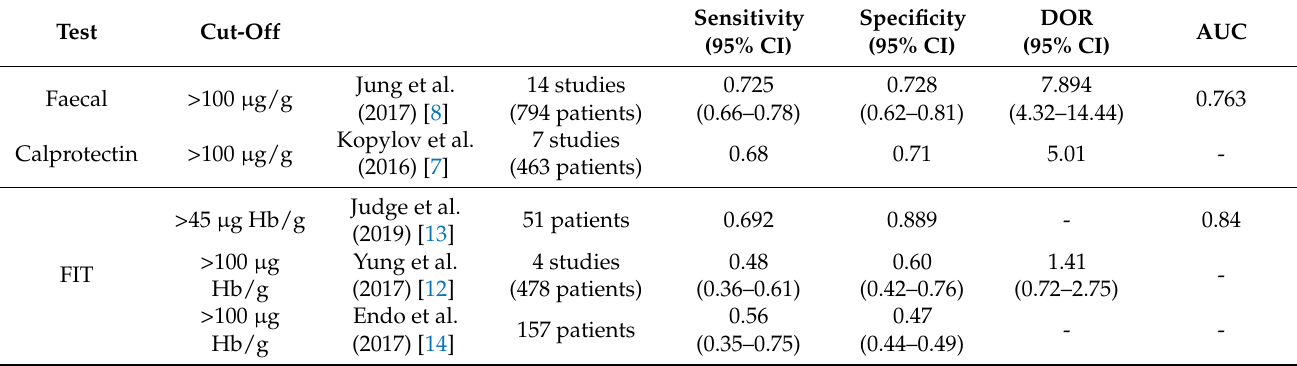
Table 1. Calprotectin and FIT test sensitivity and specificity for significant findings on capsule